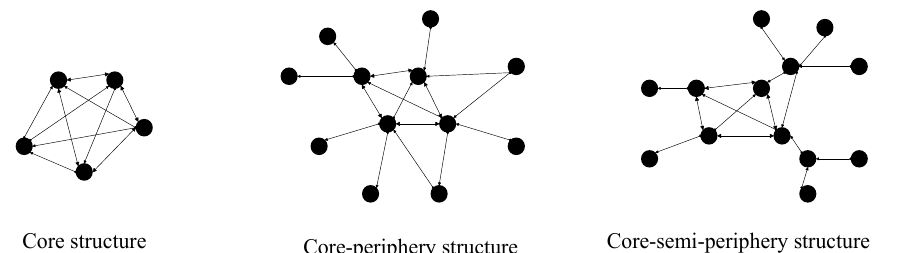
Figure 10. Types of collusive network structures.